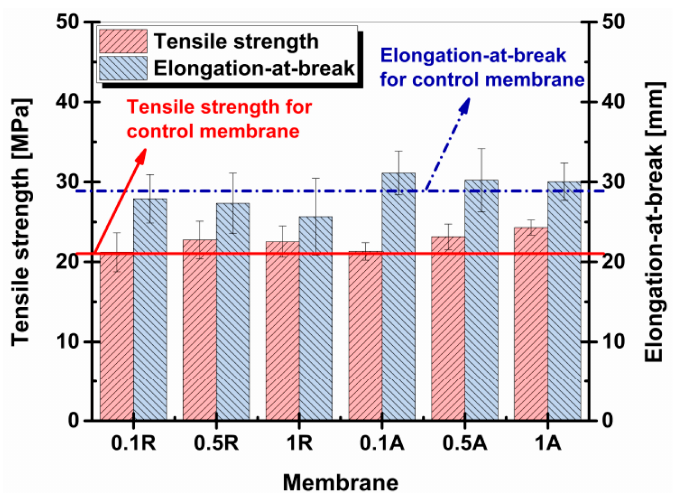
Figure 10. Tensile strengths and elongations-at-break of membranes with the addition of TiO 2 rutile and anatase (Note: Table 19.61 ± 1.8 MPa and 31.53 ± 1.3 mm, respectively).